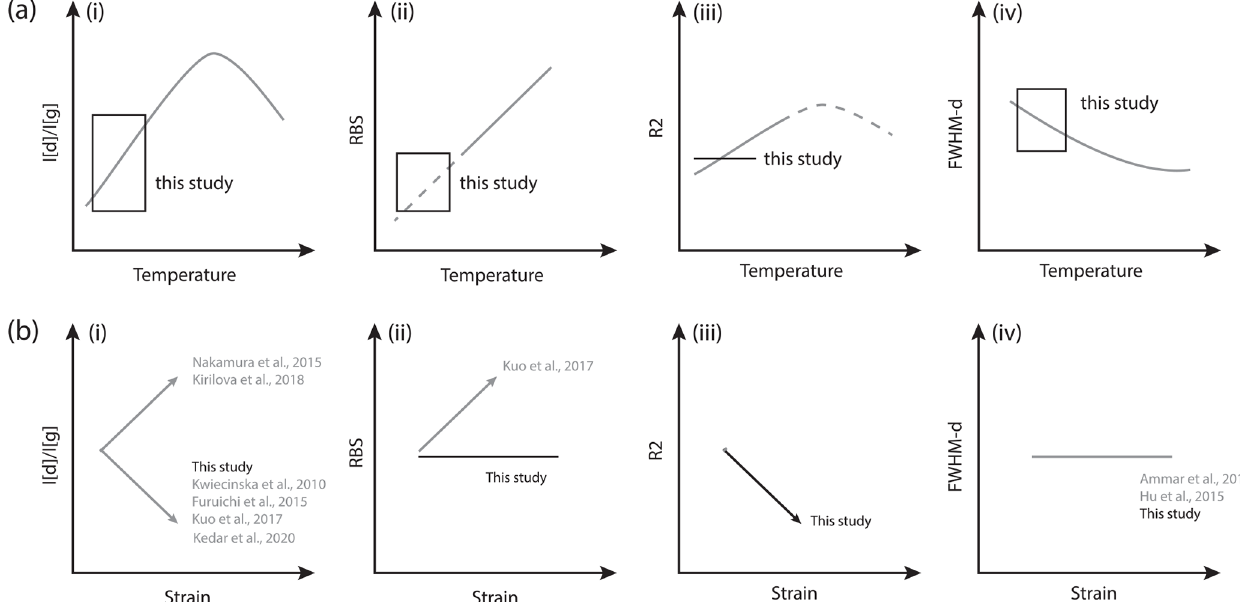
Figure 4. Typical changes in Raman spectroscopic parameters with temperature and strain, represented schematically. Exact temperature, strain, or parameter values are not stipulated, since these will vary depending on starting material. Where data from this study match the trend, the applicable zone is marked with a black box; where they differ from the usual trend, data from this study are marked with a black line representing the observed trend. Where there are two trend lines in (b) (i), this indicates the study of different carbon starting types. (a) Parametric changes with temperature: (i) intensity ratio ( I D / I G ); (ii) Raman band separation (RBS); (iii) area ratio ( R 2 ); (iv) D-peak width (FWHM[d]). (b) Direction of parametric shifts with the application of strain: (i) intensity ratio; (ii) Raman band separation; (iii) area ratio; (iv) D-peak